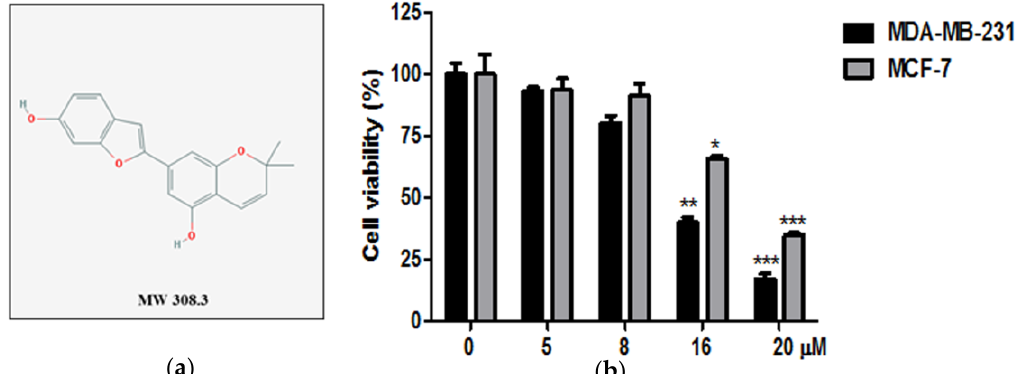
Figure 1. Effect of Moracin D on cytotoxicity in MDA-MB-231 and MCF-7 cells. ( a ) Chemical structure of Moracin D. Molecular weight = 308.3. ( b ) Cells were seeded onto 96-well plates and treated with concentrations of Moracin D (0, 5, 8, 16, 20 μM) for 24 h. Cell viability was evaluated by 3-[4,5- dimethylthiazol-2-yl]-2,5 diphenyl tetrazolium bromide(MTT) assay. Data represent means ± SD. * p < 0.05, ** p < 0.01, and *** p < 0.001.